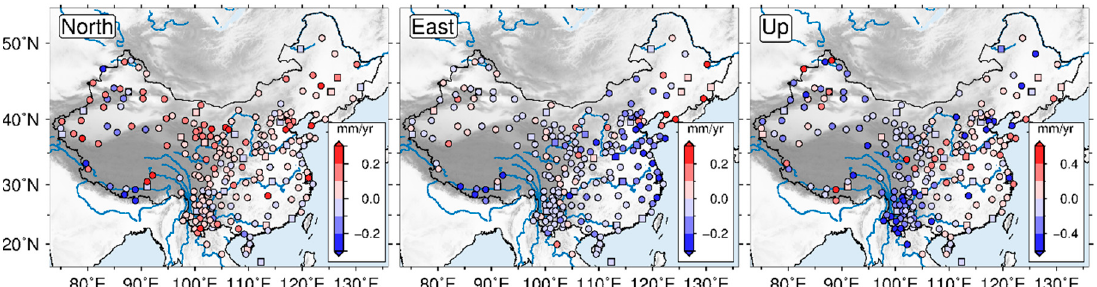
Figure 13. Velocity differences between the filtered and unfiltered time series.